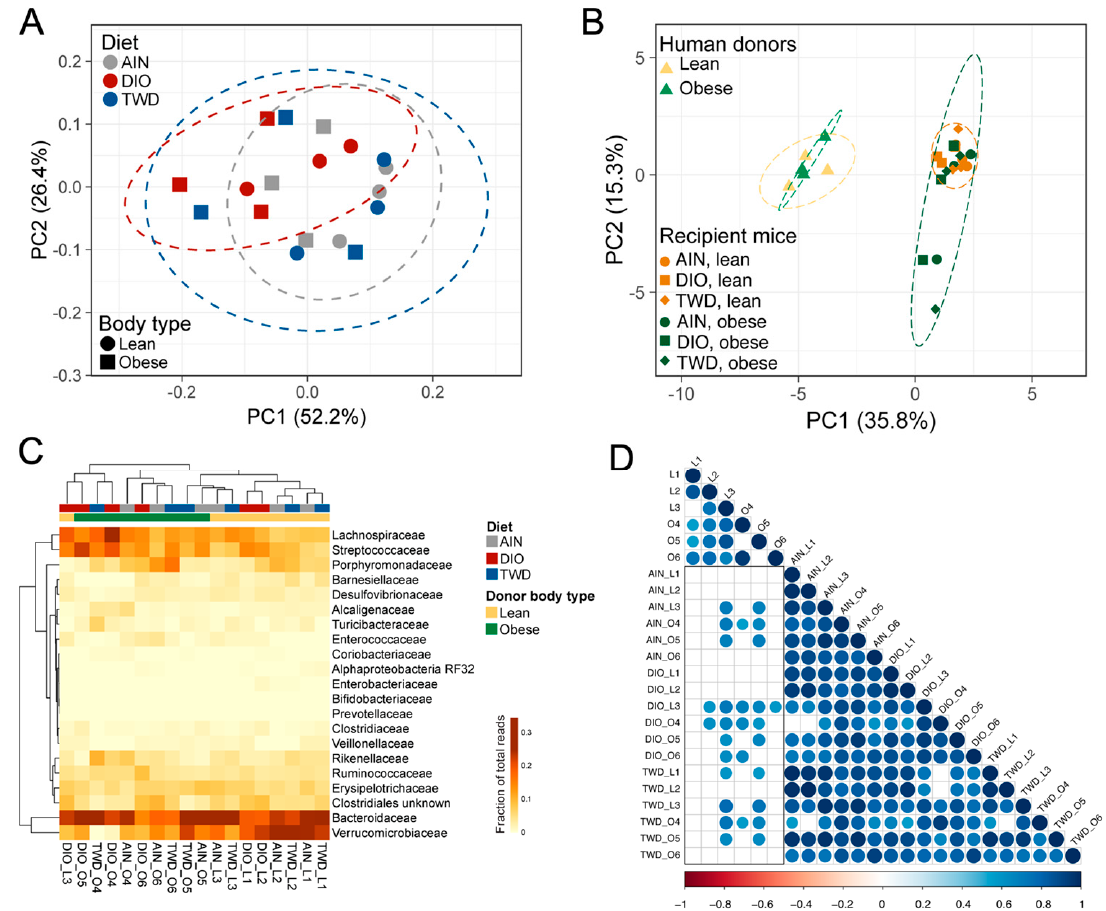
Figure 9. Hierarchical clustering and principal components analysis of recipient mouse microbiomes post-FMT. ( A , B ) Principal components analysis (PCA) of family-level taxonomy data plotted according to the first two principal components for FMT recipient mice (A), comparing recipient mice to original human donors (B). Variation attributed to each component is shown. Dashed lines represent the 95% confidence ellipse. ( C ) Unsupervised, bidirectional hierarchical cluster analysis of taxonomy relative abundance data for bacteria families comprising at least 1% of the fecal microbiome from all mice prior to antibiotic treatment (pre-AB) and from each of the six human donors (lean: L1, L2, L3; obese: O4, O5, O6). Clustering was performed using Euclidian distance with average linkage. Heatmap color scale indicates relative abundance as fraction of total reads. ( D ) Pearson correlation plot showing correlation between human donor microbiomes and recipient mice. The color scale indicates the size and direction of the correlation coe ffi cient. Only significant ( p < 0.05) correlations are shown. The black box highlights the correlation of FMT recipient mice with their human